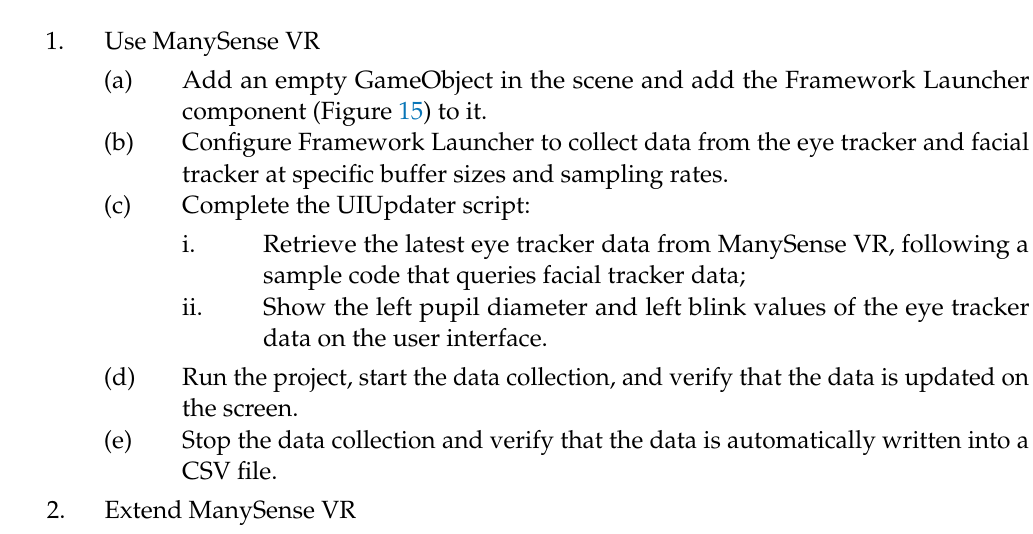
Figure 14. User interface of the skeleton project provided for the participants to